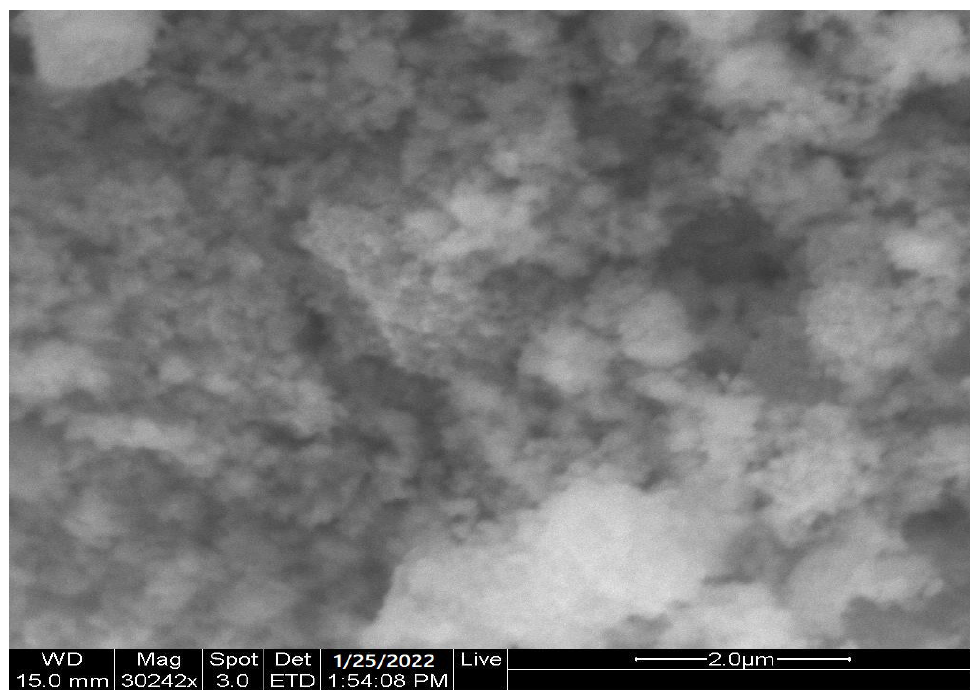
Figure 4. TGA curve for ( A ) MnFe 2 O 4 NPs, ( B ) chitosan, and ( C ) CCsMFO nanocomposite. The morphology of CCsMFO nanocomposite was explored using SEM, TEM, and EDS. SEM micrographs (Figure 5) show the irregular particle size and shape of CCsMFO nanocomposite particles. At the same time, TEM images (Figure 6) show miscellaneous flake forms with different size particles, and the particle size was measured using the “Image-J” program and expressed in Table 1. In SEM micrographs, energy dispersive X-ray spectroscopy (EDS) determines each element’s kind and weight percent. The proportion of each element after normalization is displayed in Table 2 and Figure 7. The source of Si Kα peaks detected in EDS charts breaks in using conventional Si(Li) detectors that produced a silicon internal fluorescence peak from a Si dead layer of the Si-Li detector [40].